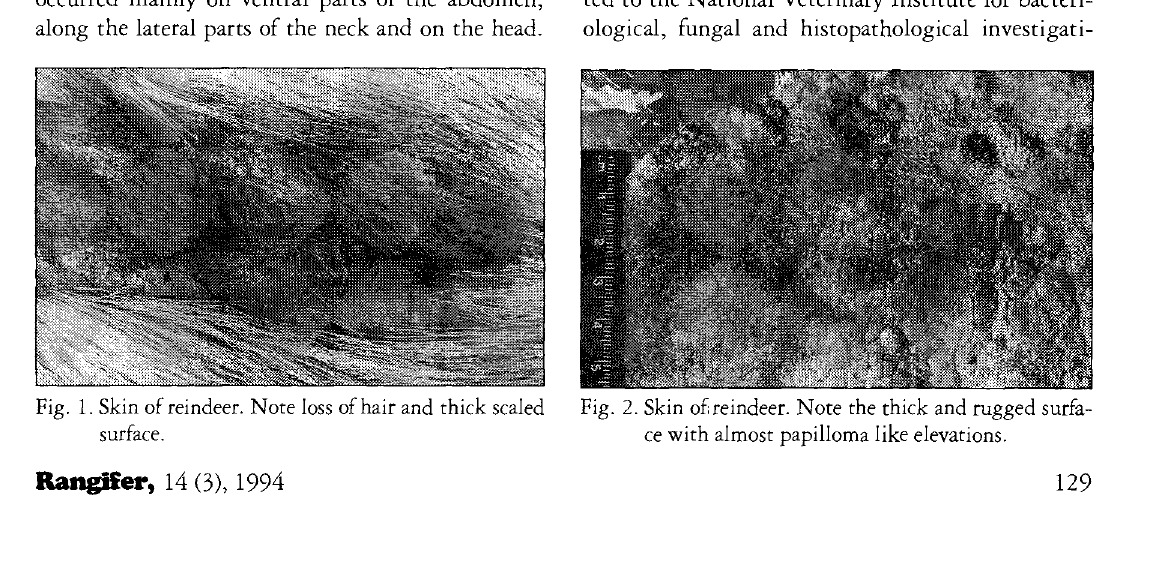
Fig. 1. Skin of reindeer. Note loss of hair and thick scaled surface.